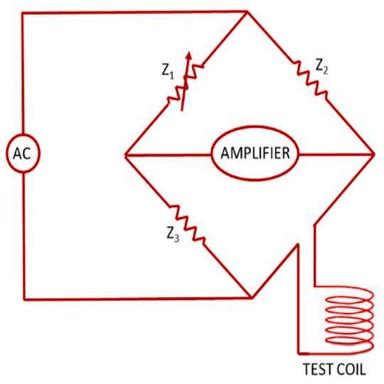
Simplified bridge circuit.